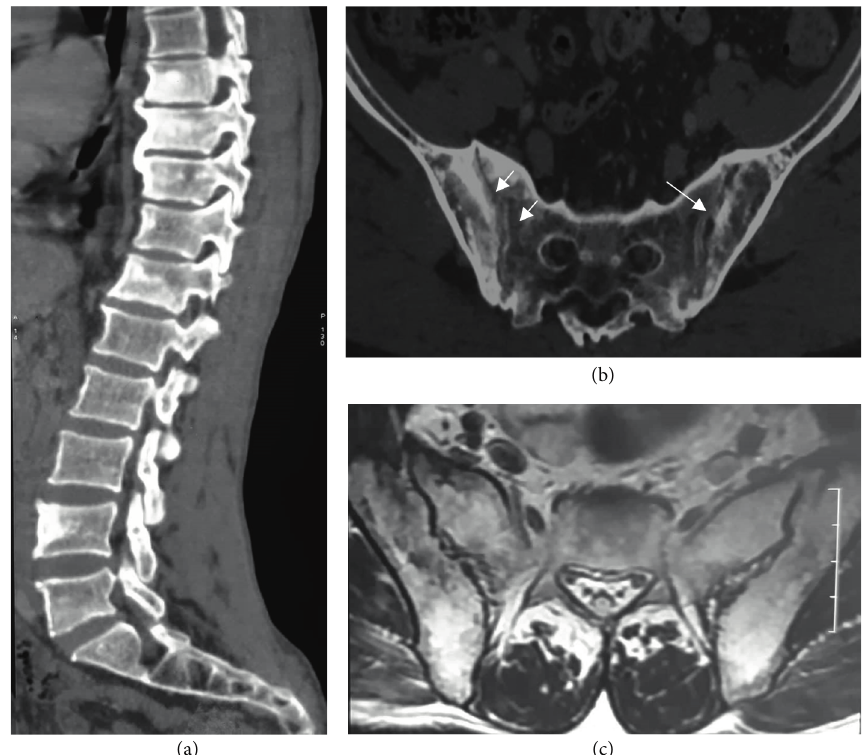
Figure 6: (a) Sagittal CTimage showing osteosclerosis of vertebral bodies of D8 to D12 and L4 with paravertebral ossifications. (b) Axial CT image showing intra-articular bridges and multiple well-defined erosions with sclerotic margins. Bone sclerosis is blurred within the trabecular bone. (c) Magnetic resonance imaging axial T1 WI showing bilateral sacroiliitis with a fatty marrow signal.